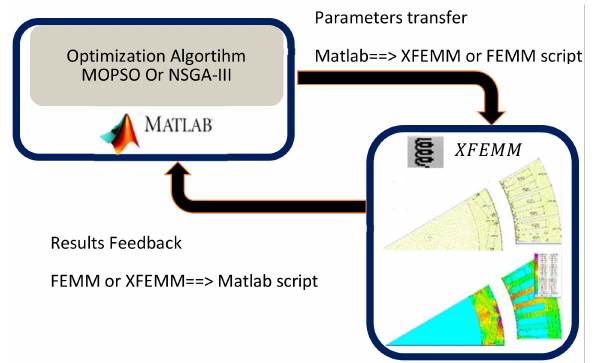
Figure 1. MATLAB and XFEMM connection for the optimization